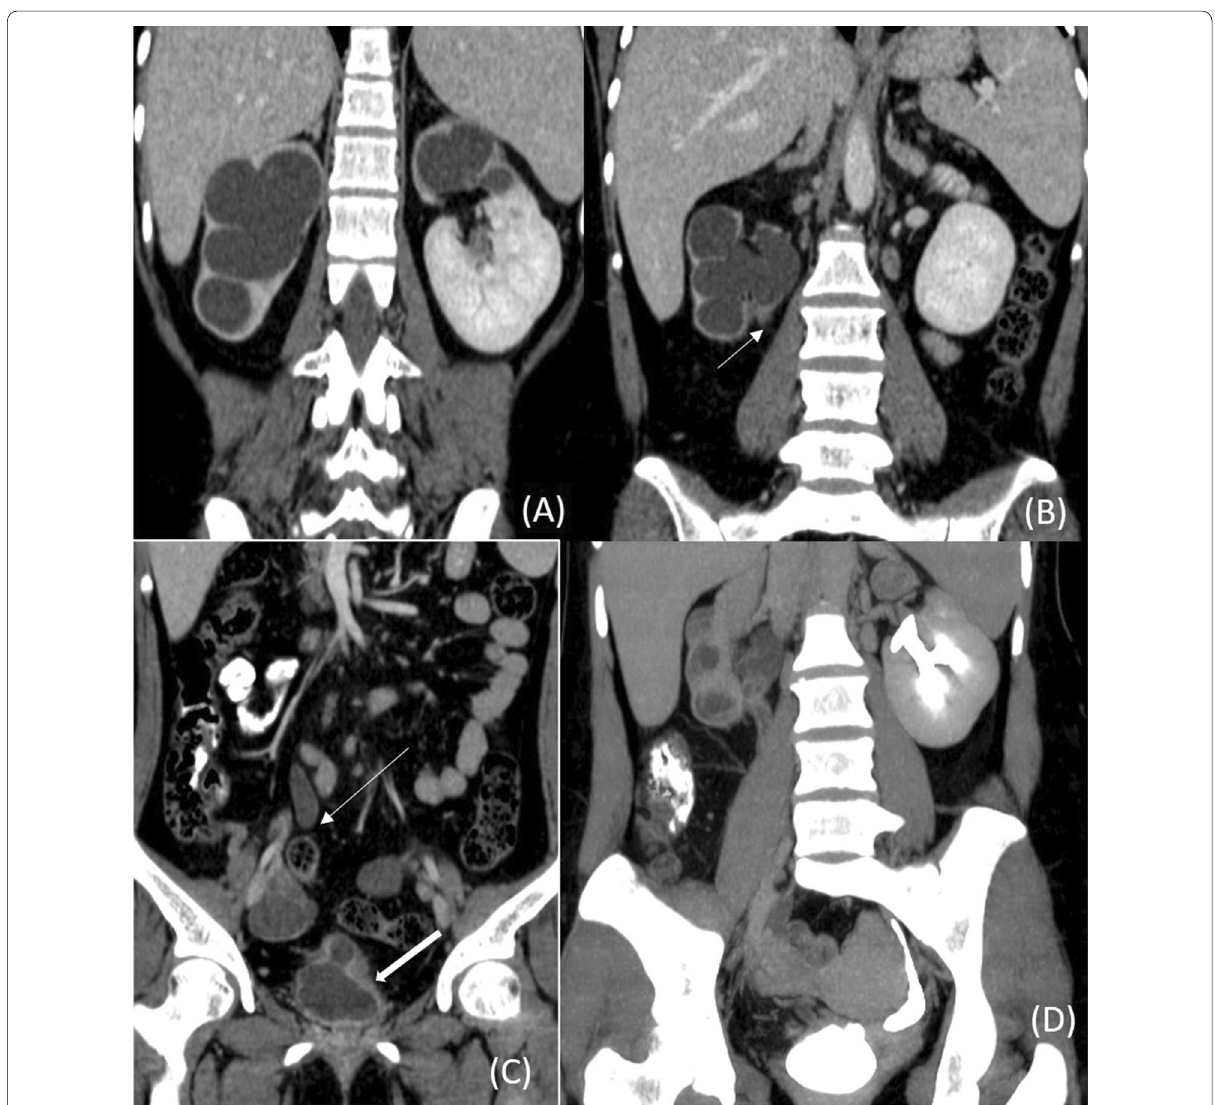
Fig. 15 Urinary tuberculosis involving bilateral kidneys, right pelvi-ureteric junction, right ureter and bladder. CT images of a 44-year-old male show gross hydronephrosis on right and upper pole caliectasis on left side ( A ), there is thickening of right pelvi-ureteric junction (white arrow in B ) and dilatation of right ureter (thin white arrow in C ), bladder is contracted, shows irregular wall thickening and a diverticulum (solid white arrow in C ), there is no contrast excretion on the right side ( D